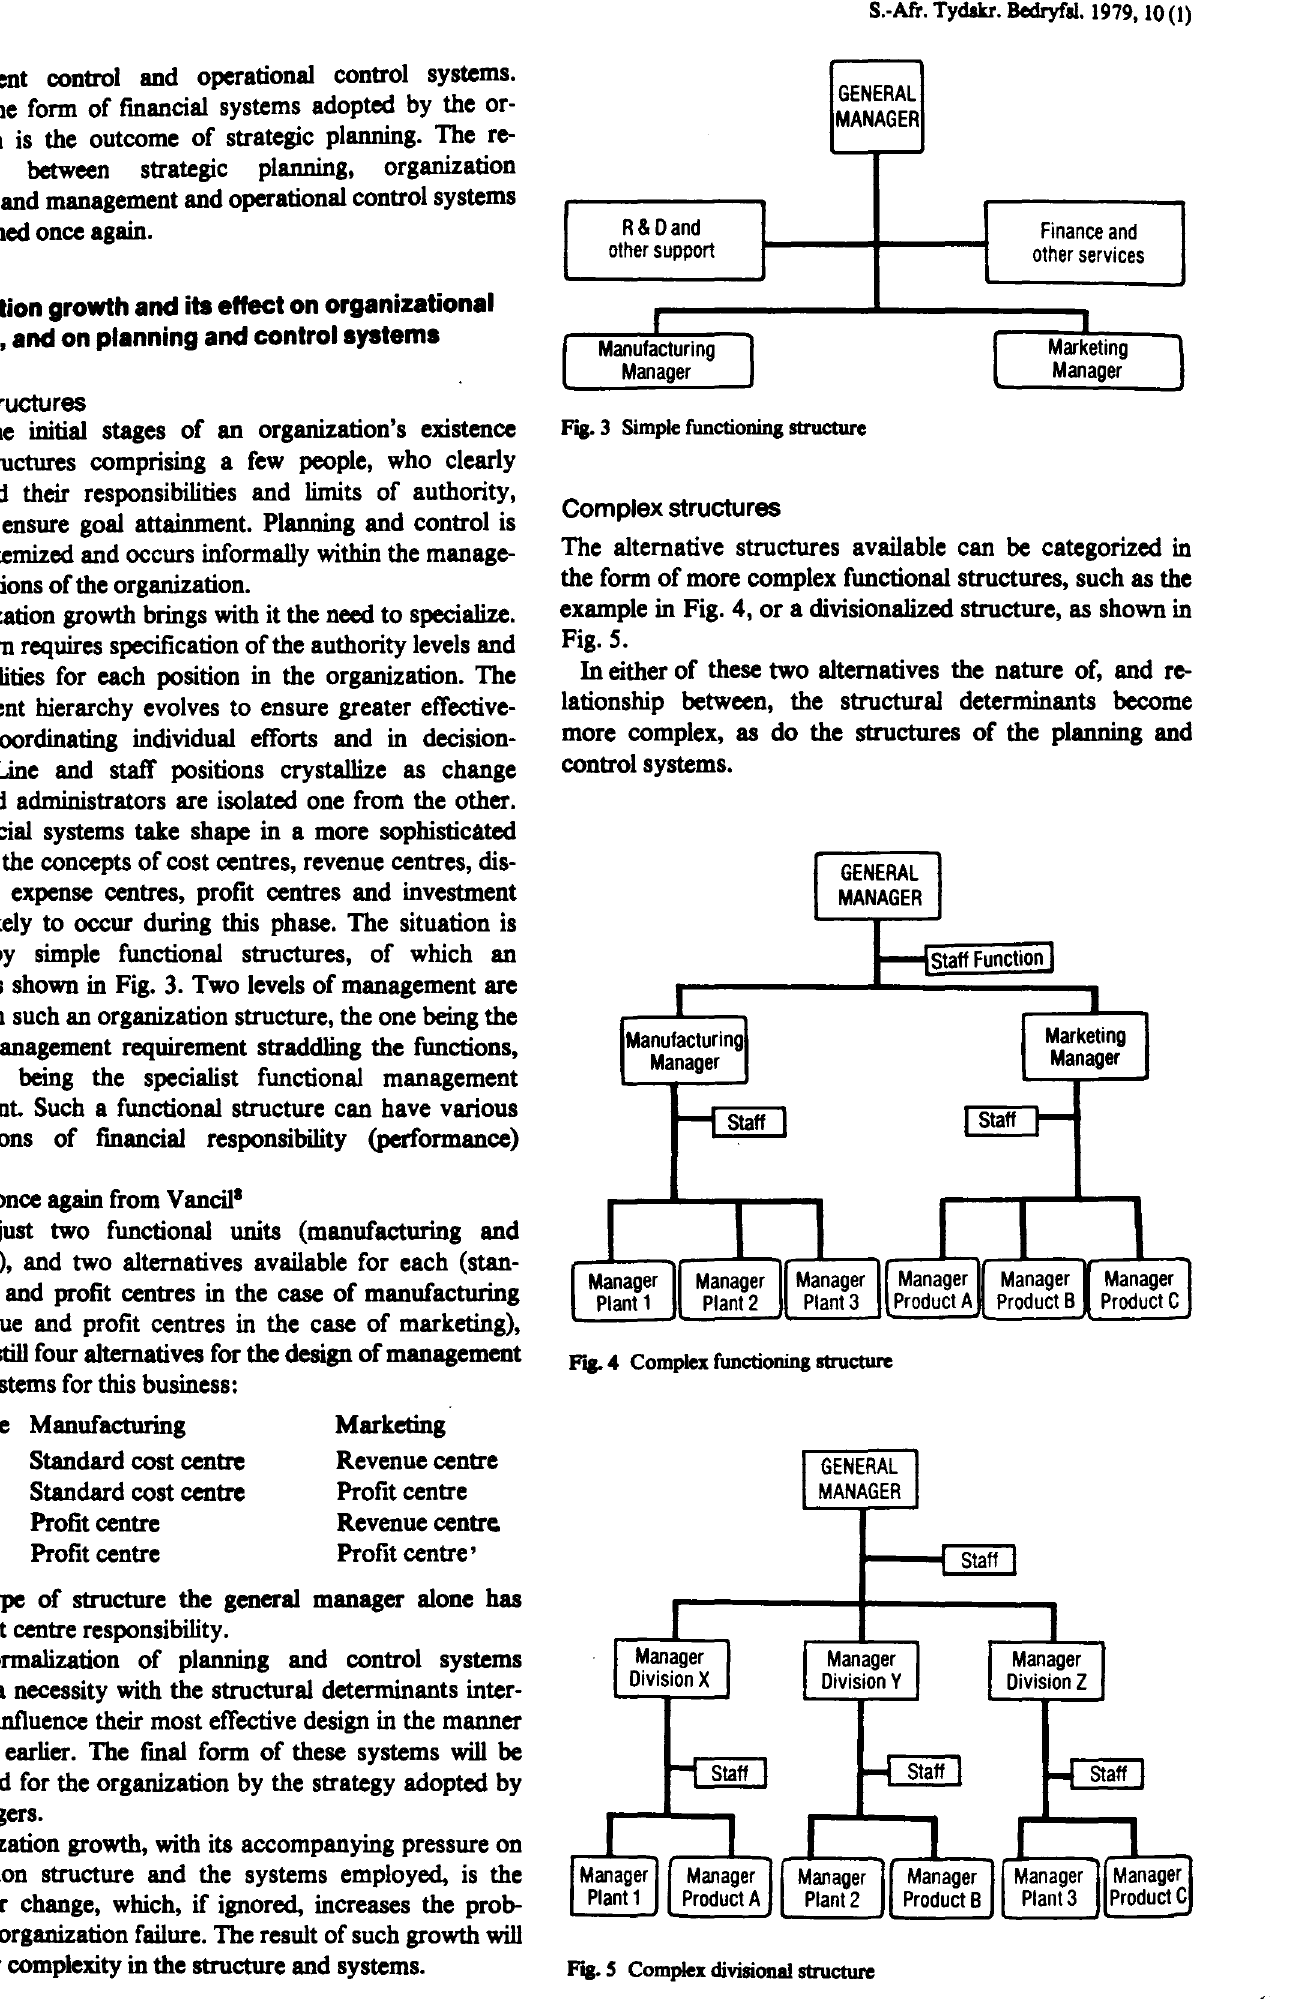
Fig. 5 Complex divisional